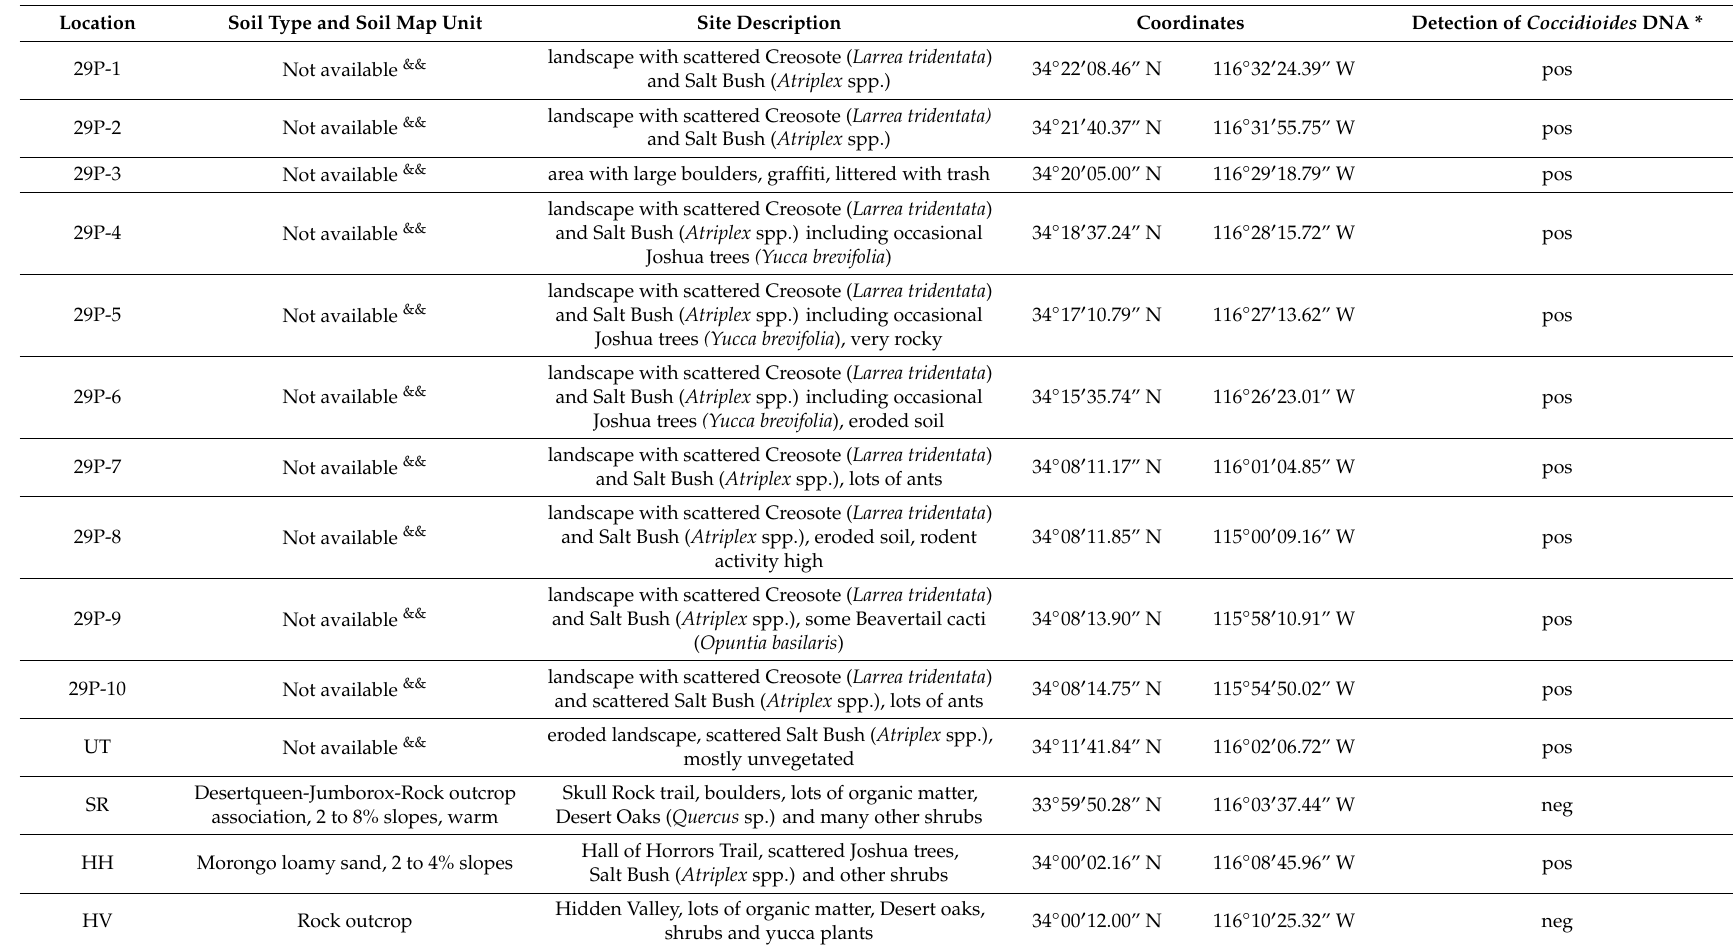
Table 4. Results of Coccidioides DNA testing at sampling sites near MCAGCC Twentynine